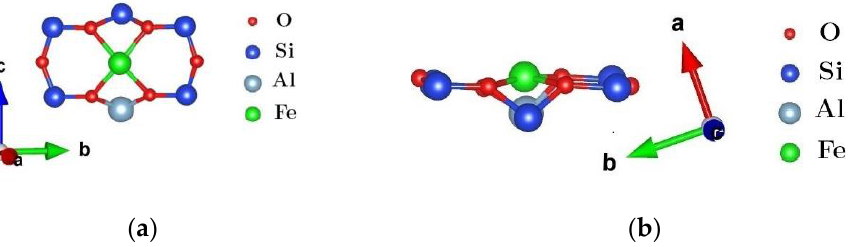
Figure 5. Configuration of a Fe atom on a 6-membered ring, shown at two distinct orientations to the crystalline axis of the mordenite unit cell: perpendicular to the a-axis ( a ) and perpendicular to the c-axis ( b ).